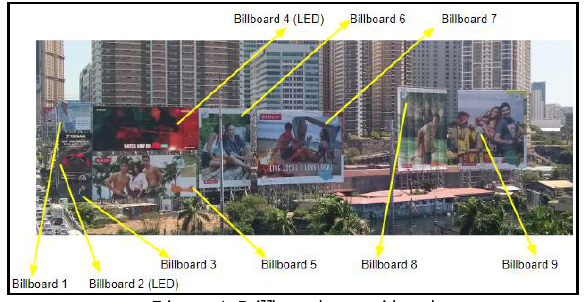
Figure 4. Billboards